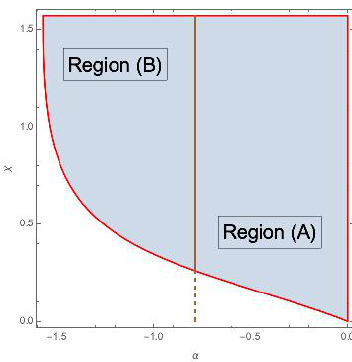
Figure 2. The light-blue region with the red boundary de(cid:12)nes the allowed region in the ( (cid:11); (cid:31) )-